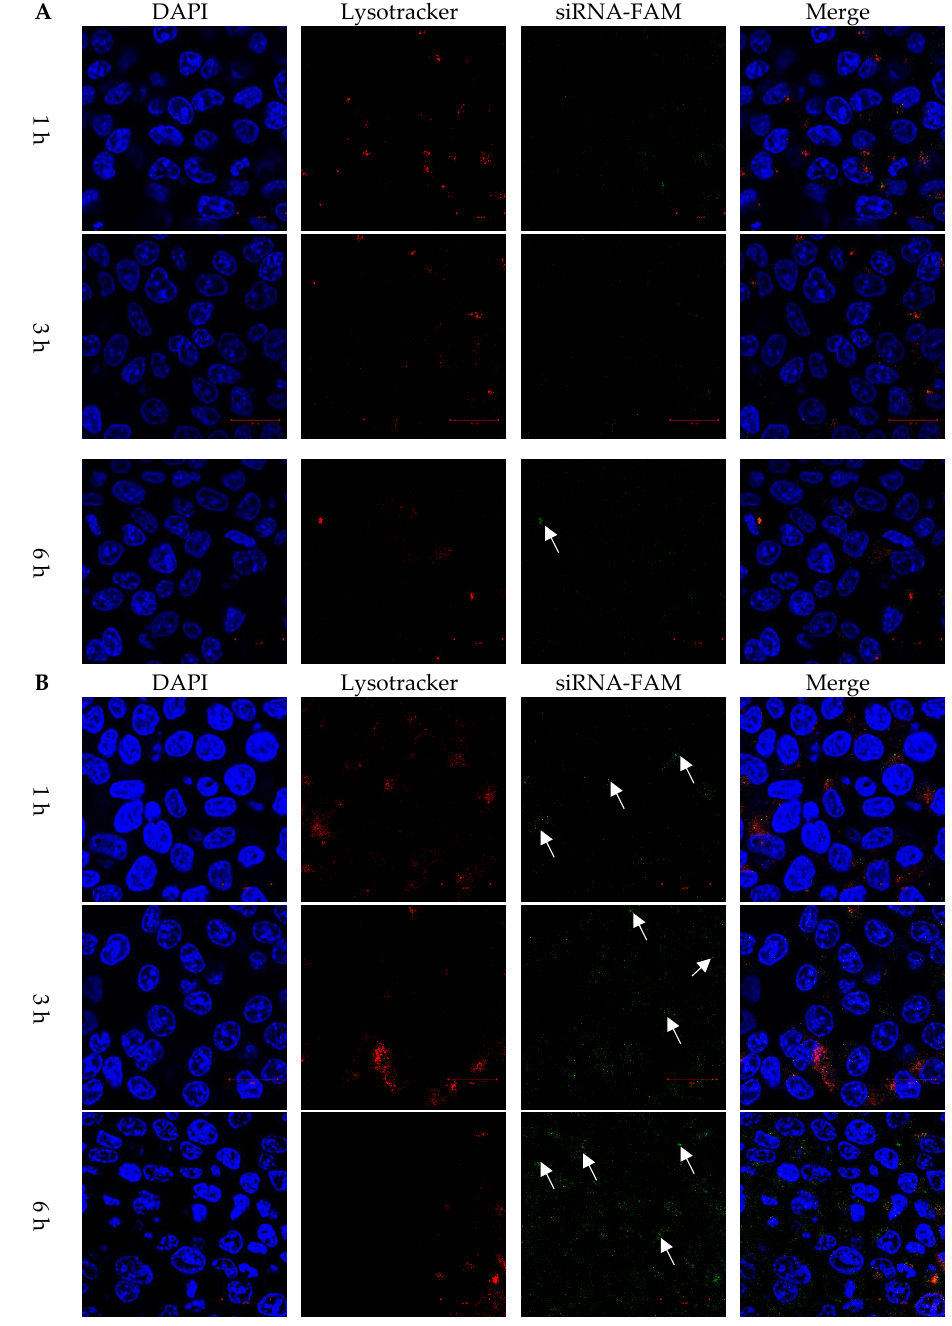
Figure 4. Cytosol delivery behaviors of siRNA from lipopolyplexes. Confocal images of HCT116 cancer cells treated with ( A ) free siRNA and ( B ) LP for 1, 3 and 6 h. The blue, red and green colors represented DAPI-stained nuclei, lysotracker stained lysosome, and siRNA-FAM, respectively. The white arrow indicated that the release of siRNA. The scale bars were 20 μm.